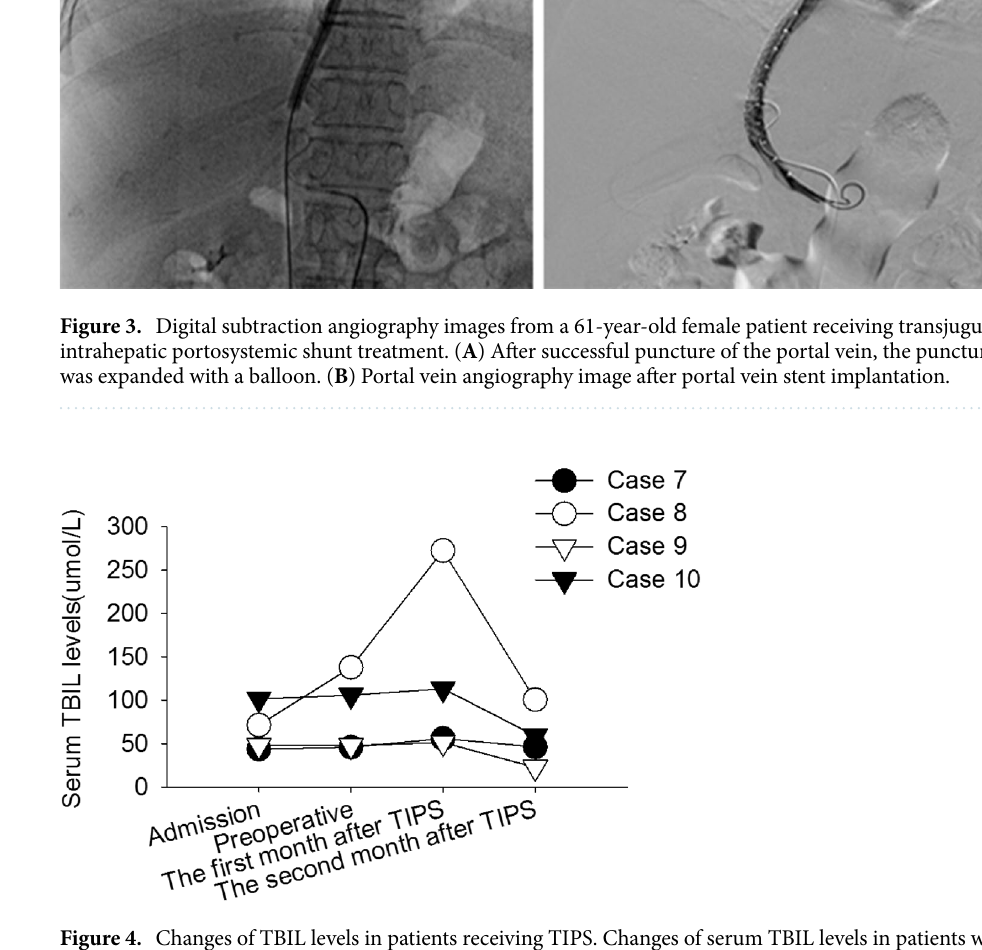
Figure 4. Changes of TBIL levels in patients receiving TIPS. Changes of serum TBIL levels in patients with PA-HSOS receiving TIPS. The patients exhibited varying degrees of elevation in TBIL levels after TIPS,